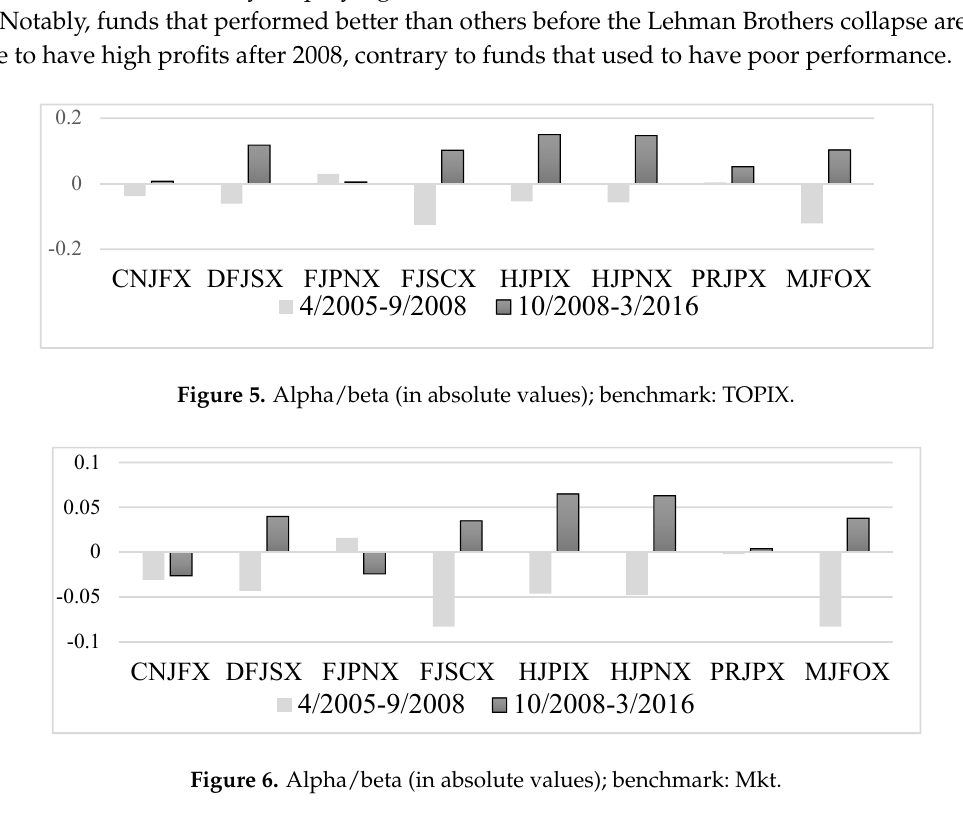
Figure 4 . Sharpe ratio of mutual funds (1 stands for 100%).